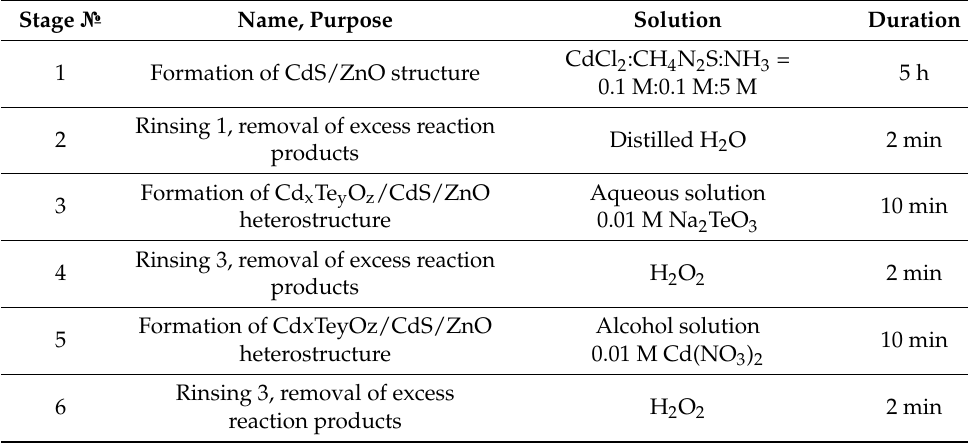
Table 1. Stages of the layer-by-layer formation of the Cd x Te y O z /CdS/ZnO heterostructure. Stage